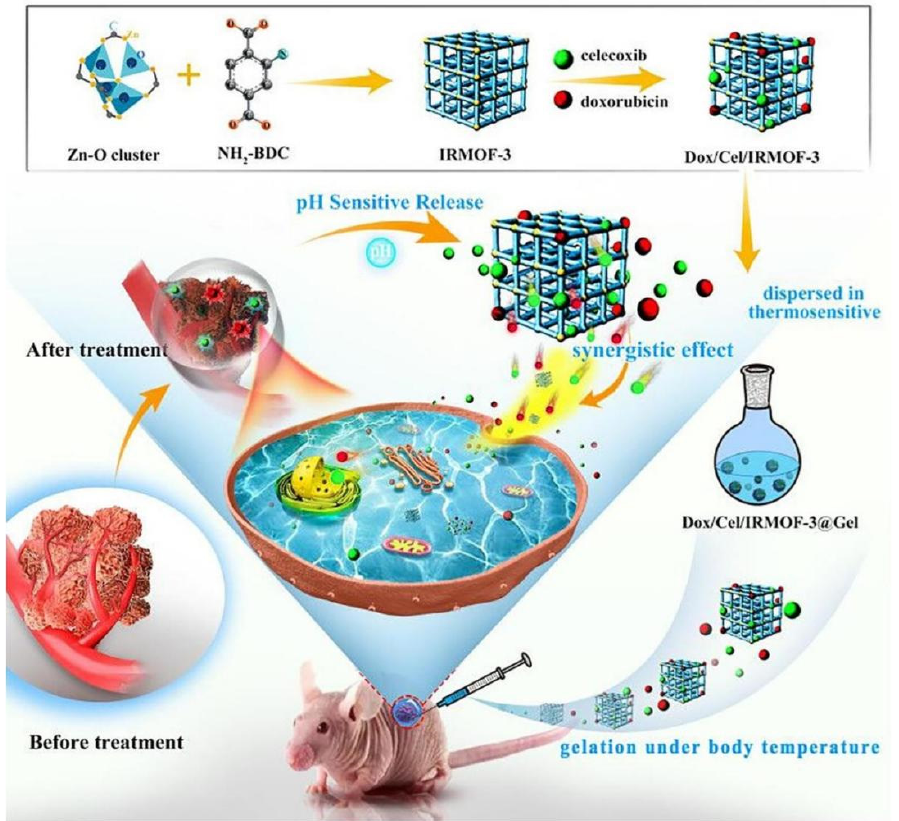
Figure 3. Schematic illustration of Dox/Cel/MOFs@Gel as novel injectable metal–organic frame- works@thermosensitive hydrogel local dual drug delivery for oral cancer therapy. Reprinted with permission [109].